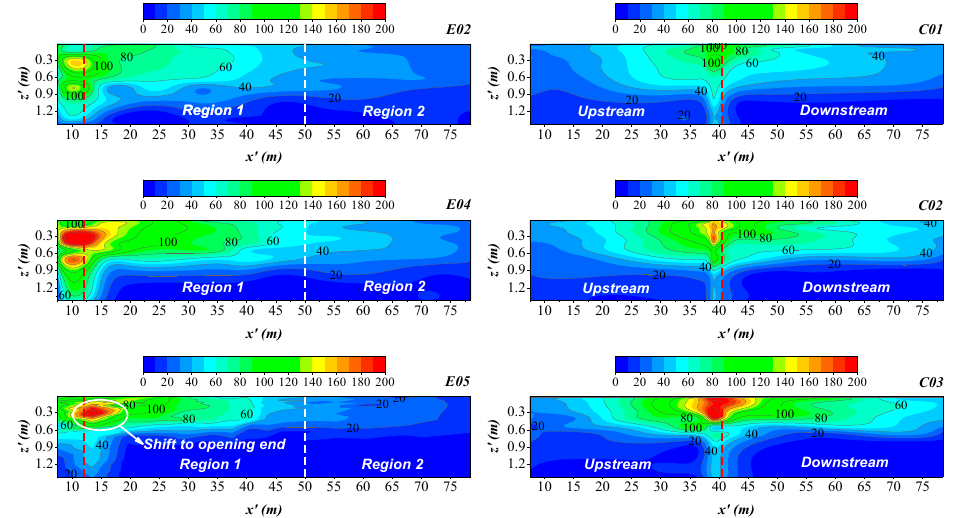
Figure 15. Temperature distribution of the hot gas layer in one-dead-end cases (Unit: K).